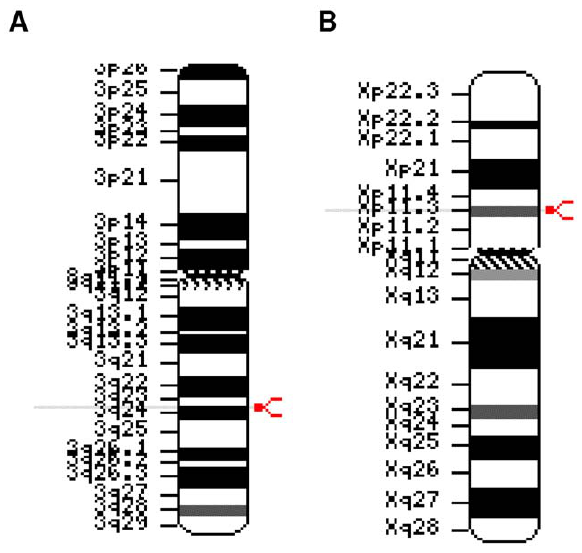
Figure 1. Chromosomal ideogram representation of the location of human DIA1(c3orf58) and DIA1R(cXorf36) . (A) DIA1 localization on human chromosome 3 at position 3q24. (B) DIA1R localization on the human X chromosome at position Xp11.3. Gene localization is indicated by a modified red arrowhead on the right-hand side, and a light-grey line extending through the text on the left-hand side.